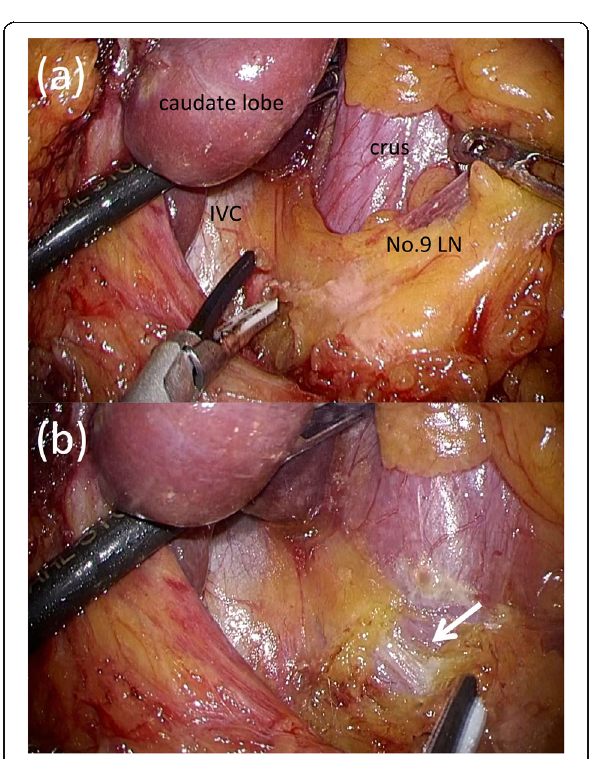
Fig. 3 Intraoperative findings. a Before lymph node dissection. b After lymph node dissection. The RIPA was exposed (arrow)